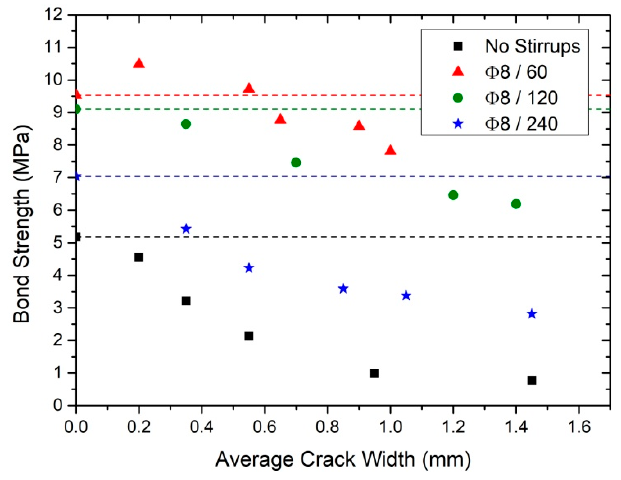
Figure 10. Bond strength values in function with average crack width.